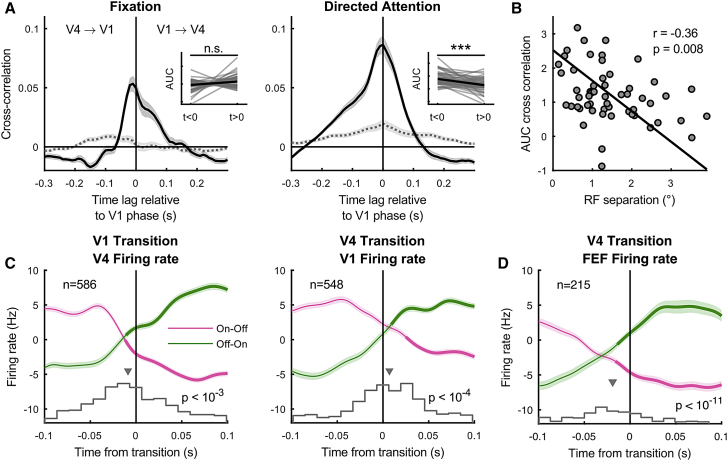
Interareal coordination of cortical state(A) Cross-correlation between time series of On-Off phases in V1 and V4 relative to V1 phase during fixation (left) and after cue onset (right). Insets show the area under the cross-correlation curve for times smaller and larger than zero. The dashed gray line depicts the shuffle predictor.(B) RF separation plotted against the area under the cross-correlation curve during attention (from the right panel of A). The line indicates the standardized major axis regression fit.(C) Spiking activity in one area aligned to state transitions in the other area, averaged across channels and recordings. Only epochs without transitions preceding or following the alignment transition within 100 ms were included. Thick green and pink lines indicate the times the firing rate was higher (green) or lower (pink) than the average rate (false discovery rate [FDR] corrected, one-sided Wilcoxon signed rank test). Along the bottom are the histograms of the crossing point of 2 straight lines fit (least-squares) to the transition-aligned multiunit firing rate.(D) Conventions as in (C), but from a different dataset in which activity was recorded simultaneously from V4 and FEF.Statistics: two-sided Wilcoxon signed rank test (A, C, and D), Pearson correlation (B). Data are represented as means ± SEMs across channels.See also Figure S6.